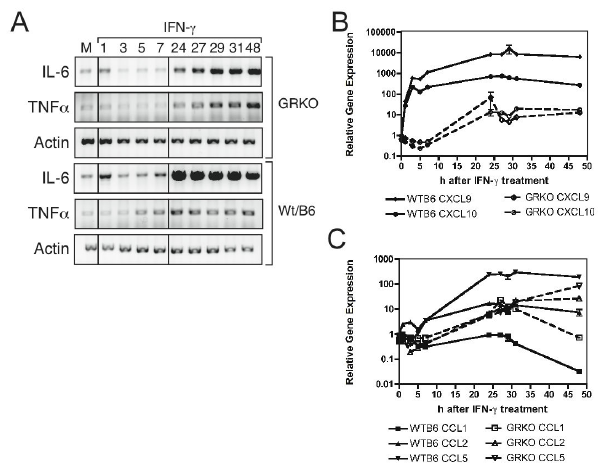
Figure 9. Cytokine and chemokine mRNA induction after treatment of WTB6 and GRKO MEFs with IFN- gamma. Total RNAs were collected from WTB6 and GRKO MEFs at various times after IFN-gamma treatment (100 U/mL) and assessed for levels of mRNA. (A) Changes in IL-6 and TNF-alpha mRNAs as determined by RT-PCR. Results representative of 3 experiments are shown. (B) Changes in levels of CXCL9 (diamonds) and CXCL10 (circles) mRNAs in WTB6 (solid lines) and GRKO (dashed lines) MEFs by qRT- PCR. (C) Changes in levels of CCL1 (squares), CCL2 (triangles) and CCL5 (inverted triangles) mRNAs in WTB6 (solid lines) and GRKO (dashed lines) MEFs by qRT-PCR. Data were normalized to GAPDH expression and are presented as mean +/- SEM of triplicate samples and are representative of three experiments.